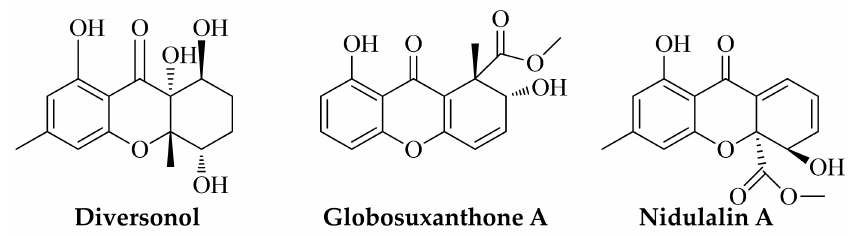
Figure 1. Biologically active